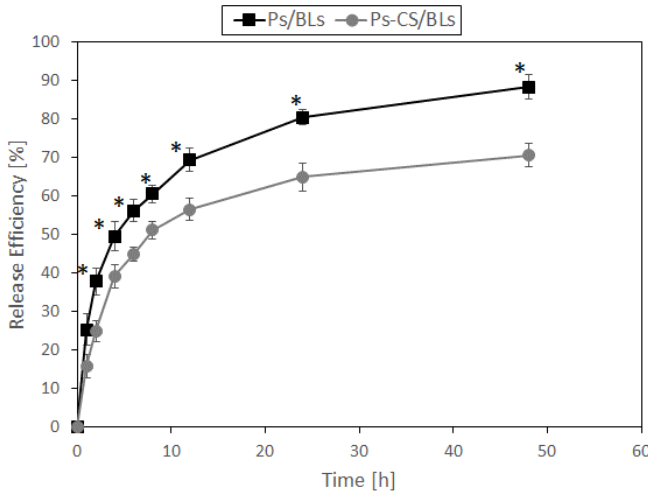
Figure 3. Release efficiency% of Ps from Ps/BLs and Ps-CS/BLs at 37 °C, into phosphate buffer (pH 7.4). Data represent means ± SD (n = 3). p -values < 0.05 were considered statistically significant, as indicated by * for comparing Ps-CS/BLs to Ps/BLs.